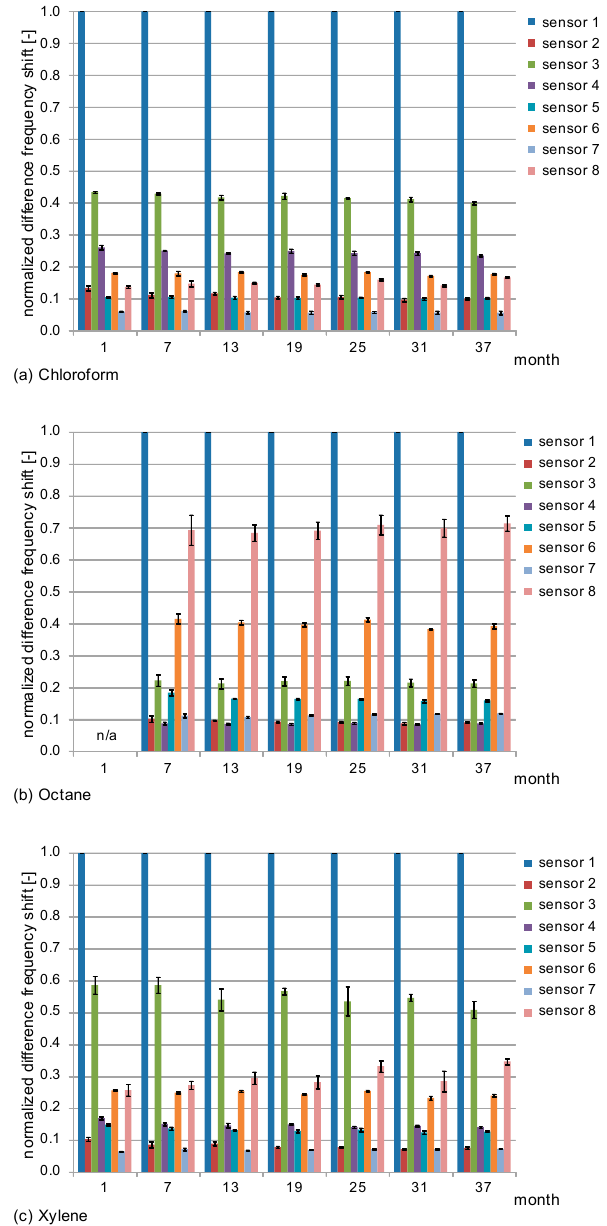
Figure 8. Normalized difference frequency shifts obtained with the STW sensor array. Samples were ( a ) chloroform, ( b ) octane, and ( c ) xylene. One representative measurement was chosen from each of the three solvent vapor concentrations; and the difference frequency shifts of all sensors were normalized to the corresponding difference frequency shift of sensor 1 (i.e., the maximum difference frequency shift). Columns represent the means; error bars represent the standard deviations of the measurements ( n = 3).